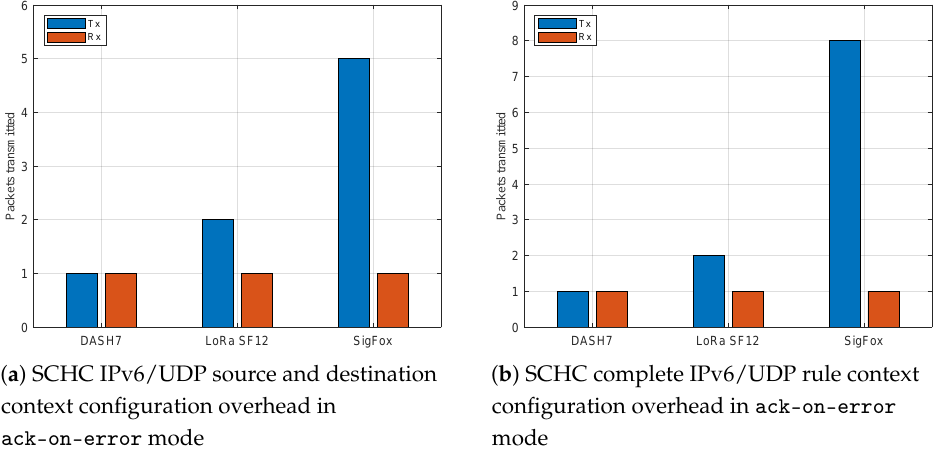
Figure 15. SCHC IPv6/UDP context